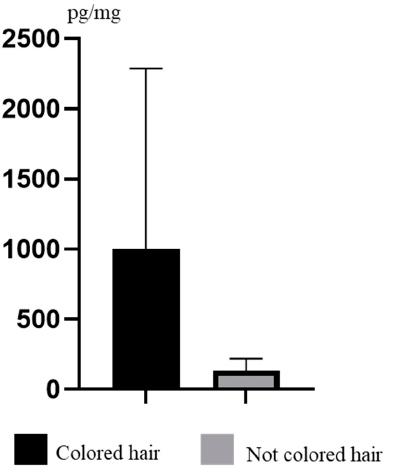
Figure 5. Mean concentration levels (±SD) of TCS in persons with colored and non-colored hair.